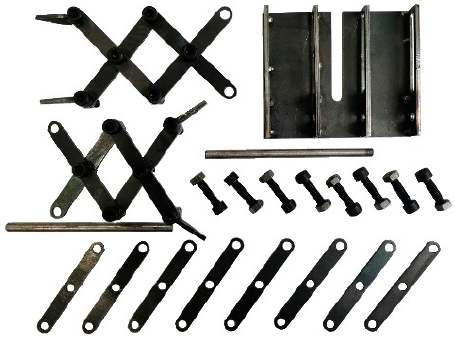
Figure 16. Components of the pick-up device.